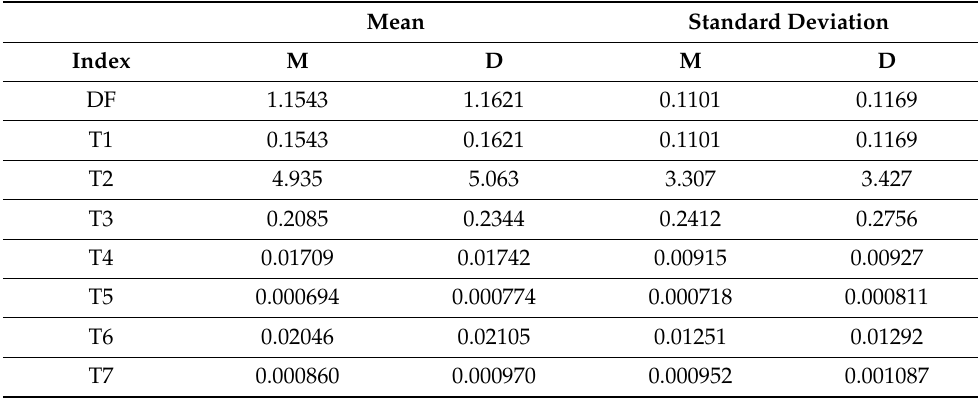
Table 4. Mean and standard deviation for the 40 pairs of selected vessel segments of each index and frame center (M, macula and D, optic disc).